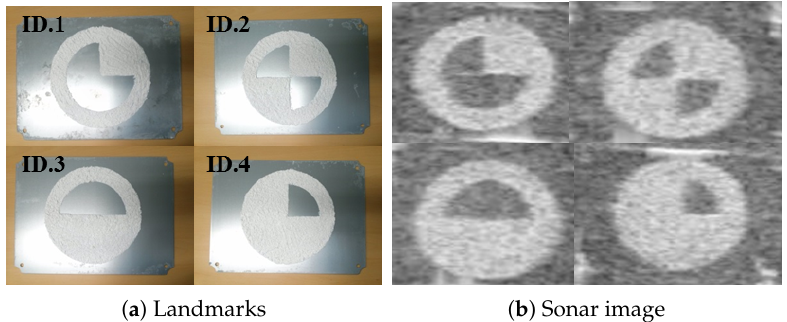
Figure 1. Developed artificial landmarks for imaging sonar: landmarks are manufactured using the differences in acoustic reflection based on their surface